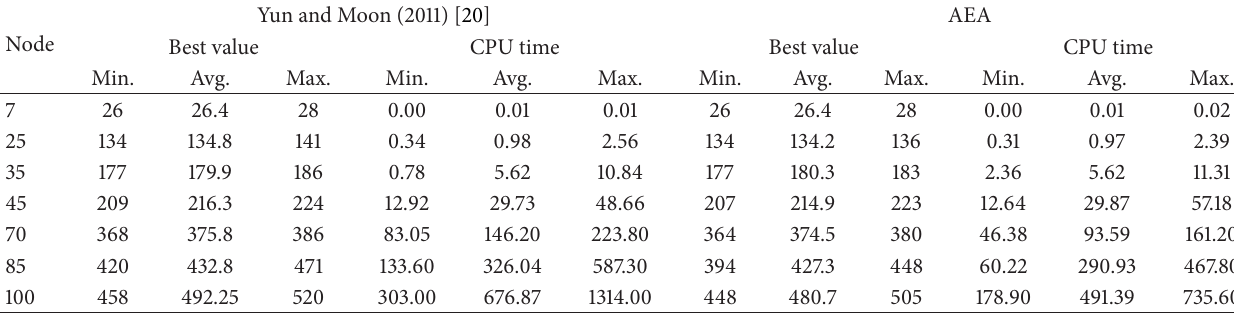
Table 4: The performance experiment result 3.